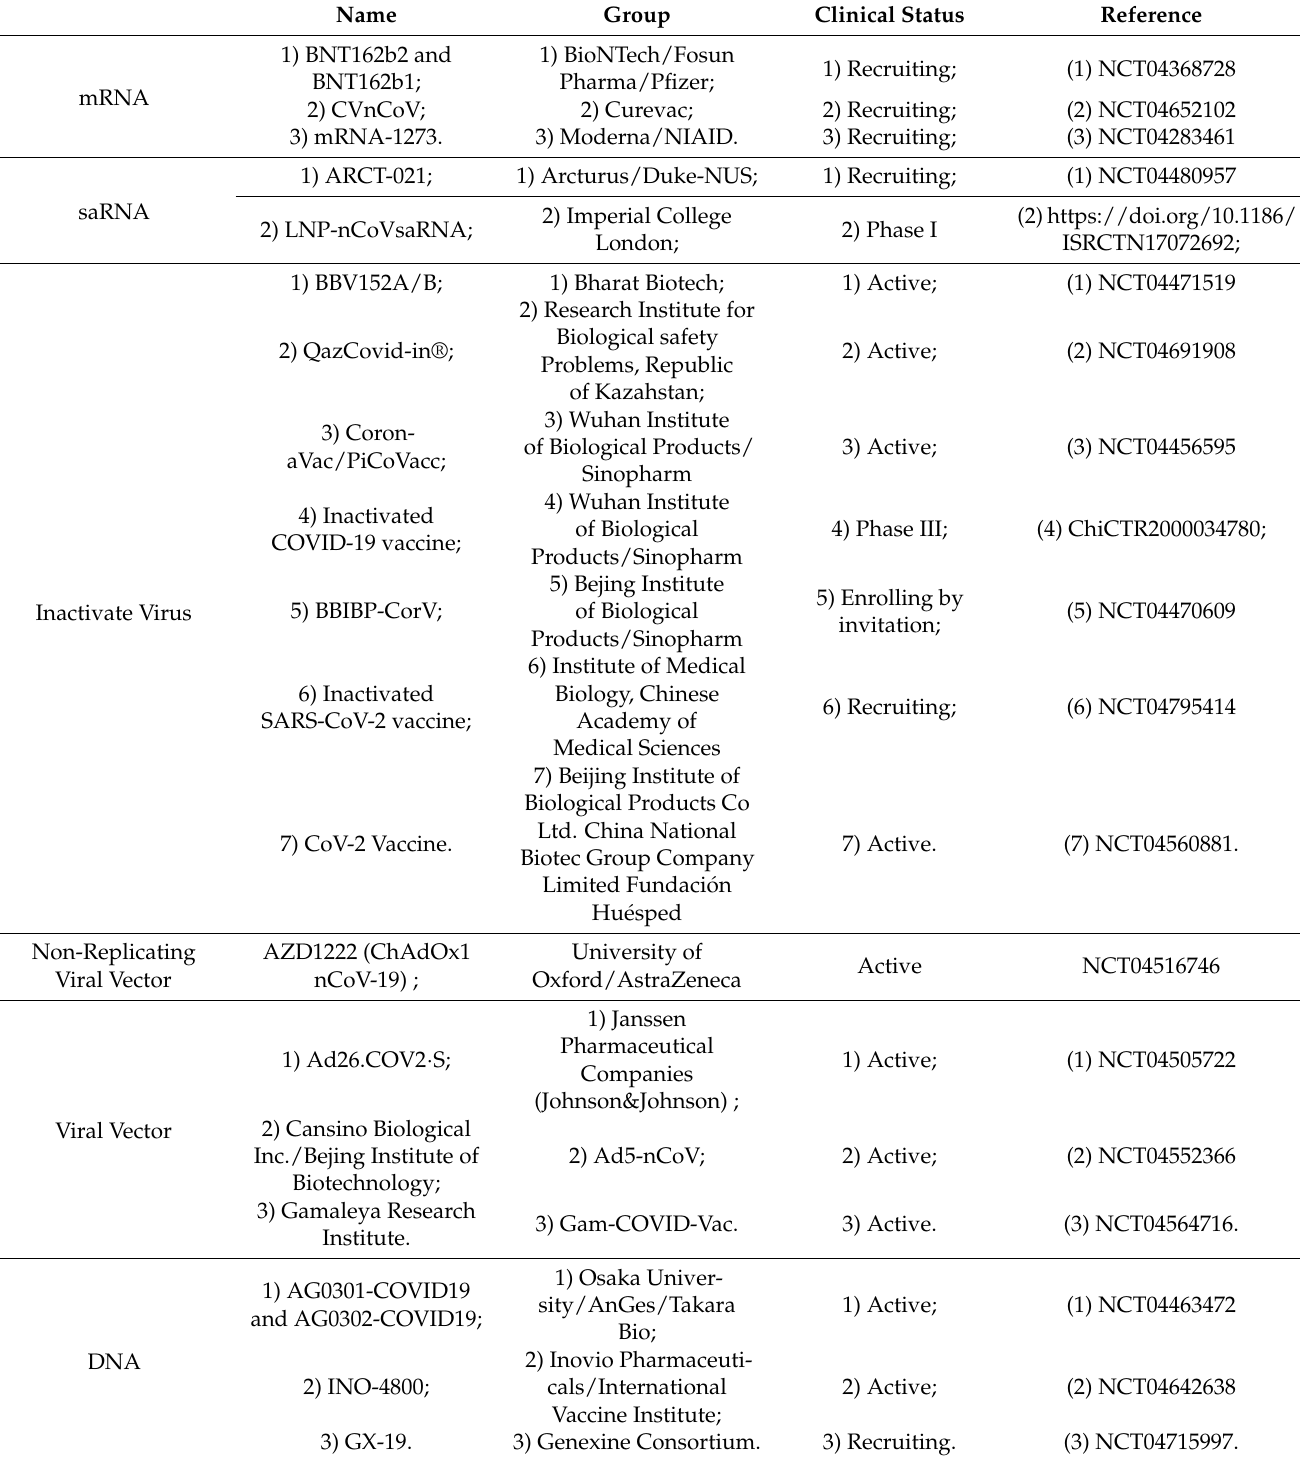
Table 4. List of principal vaccines against SARS-CoV-2. In the table are indicated the type of vaccine such as messenger RNA (mRNA) , self-replicating RNA (saRNA) , Inactivate Virus, Non-Replicating Viral Vector, Viral Vector and DNA. Each type of vaccine is associated with its specific name and the name of the